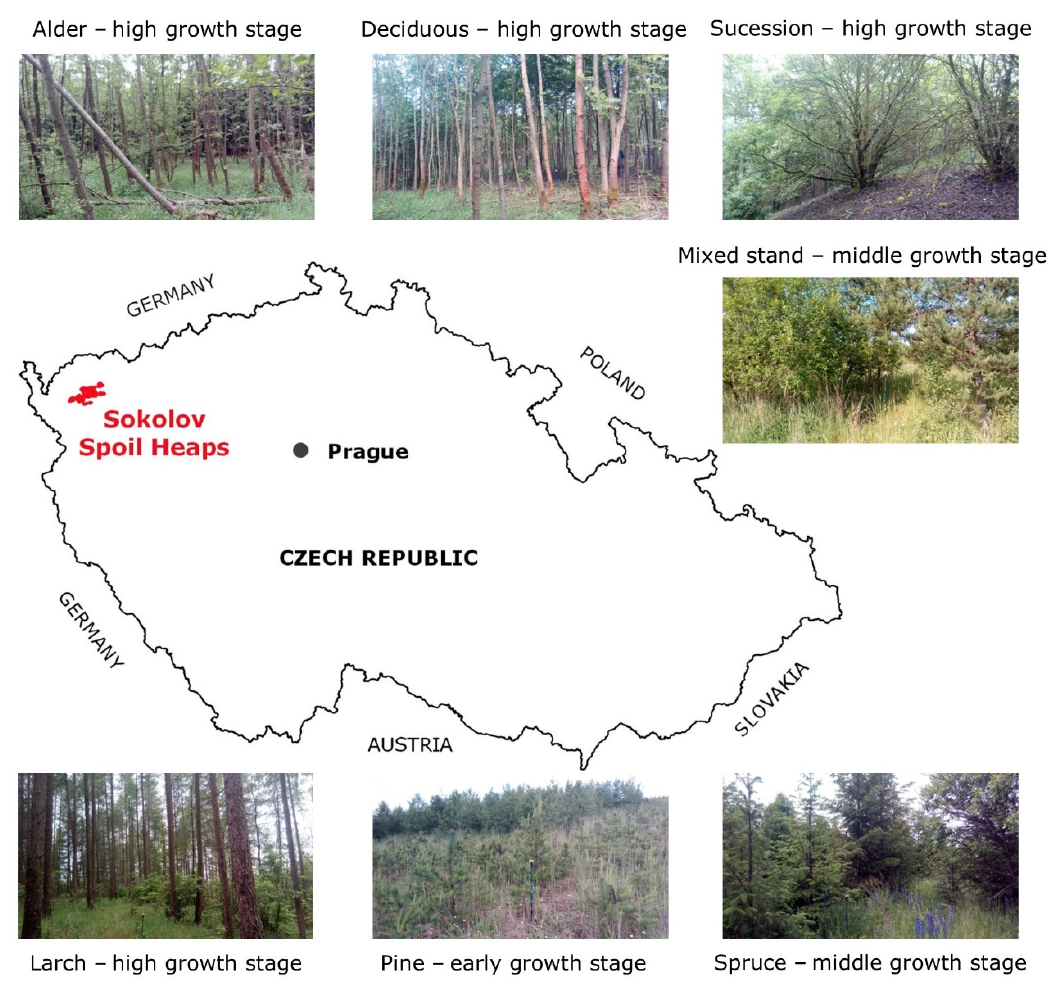
Figure 1. The geographical location of the Sokolov spoil heaps in the Czech Republic and the visualization of seven types of restored forest stands.